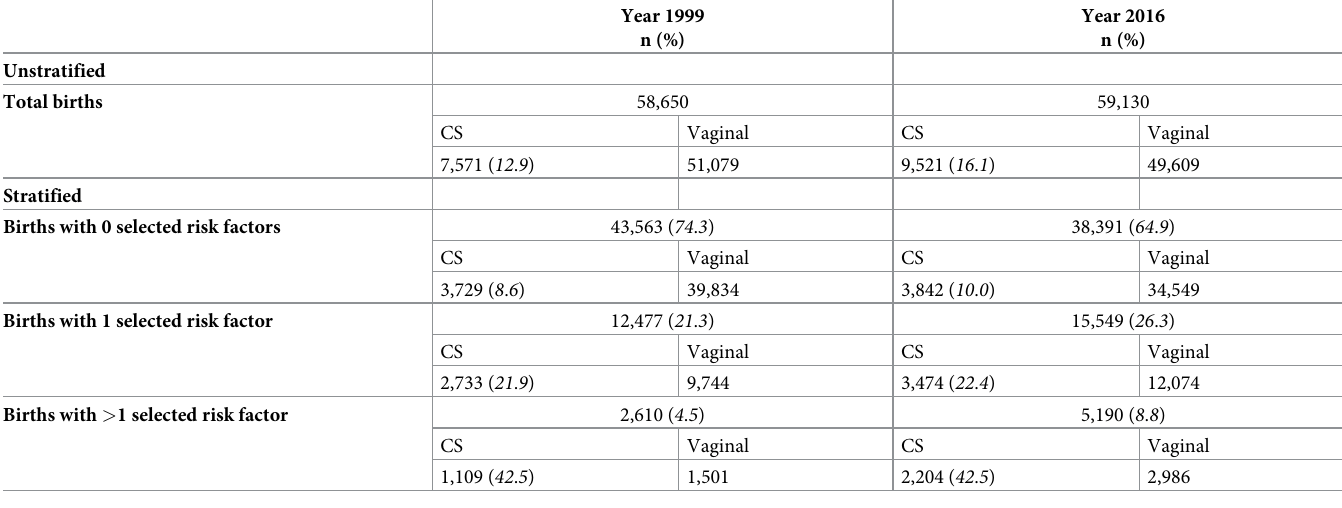
Table 2. Observed number of total births, vaginal births, and CS births in 1999 and